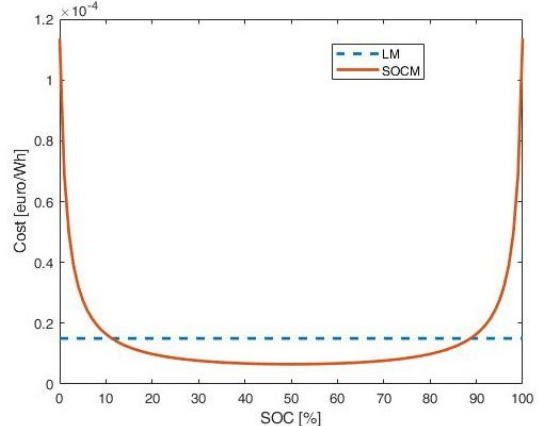
Figure 8. Cost function for LM (dashed blue line) and SOCM (solid red